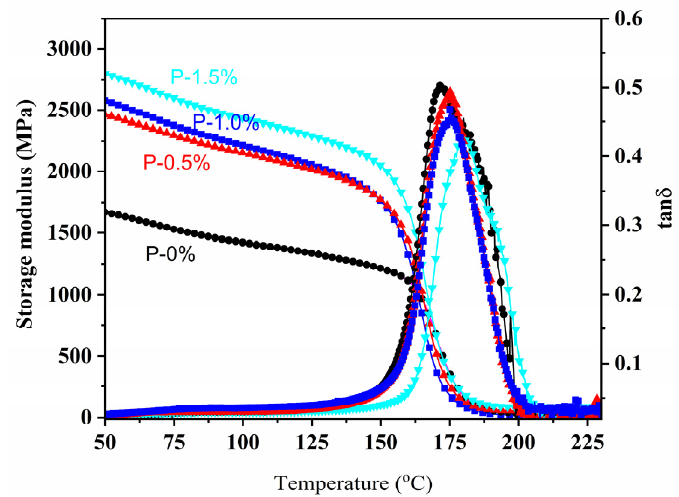
Figure 9. DMA curves of epoxy resins.